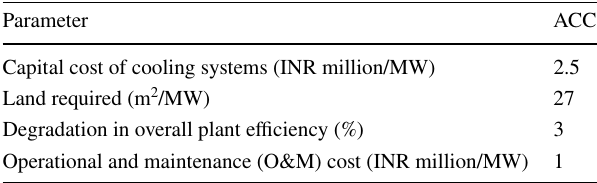
Table 2 Inputs for estimating cost of electricity generation with ACCs